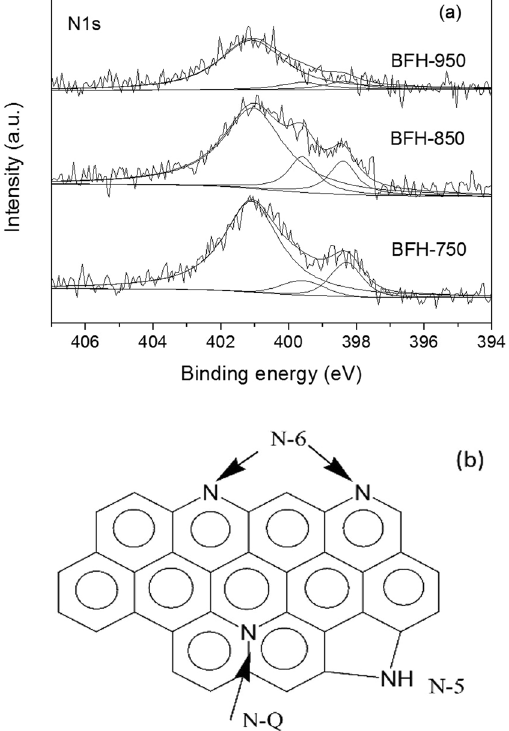
Figure 5. ( a ) XPS spectra of N1s for BFH-750, BFH-850 and BFH-950, ( b ) possible structure of N species doped on